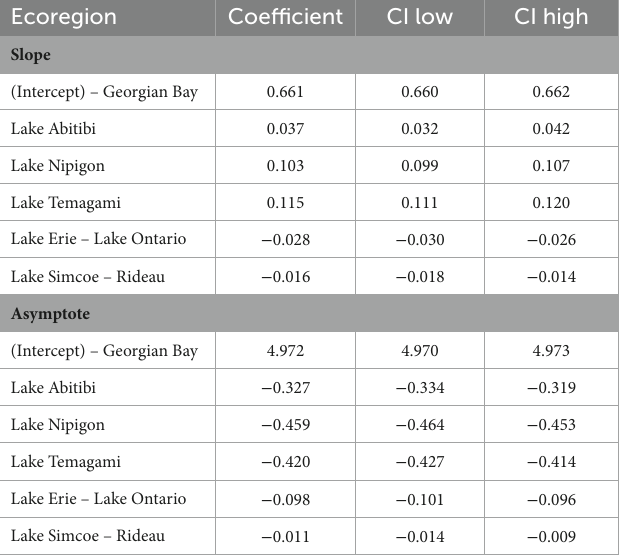
TABLE 3 Results of GAMs showing the ecoregion estimates and 95% CI for both slope and asymptote.